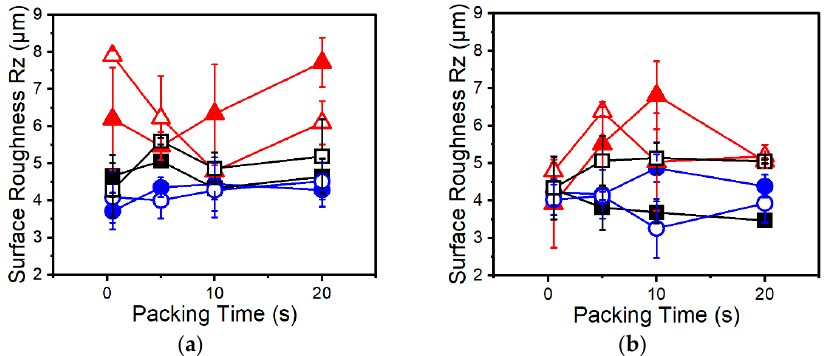
Figure 7. Surface roughness of Resin A (red triangles), Resin B (blue circles), and Resin C (black squares) samples foamed using ( a ) AV CBA and ( b ) UC CBA under various packing times. Closed and open symbols indicate 1 wt% and 2 wt% CBA, respectively. and open symbols indicate 1 wt% and 2 wt% CBA,